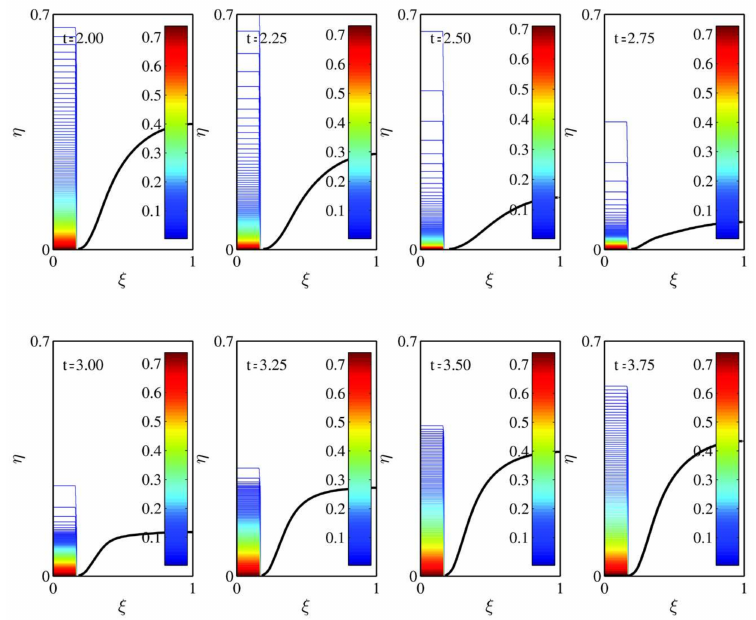
Figure 5. Evolution of normalized mass fraction of liquid fuel—without droplet grouping; the solid black lines represent the flame